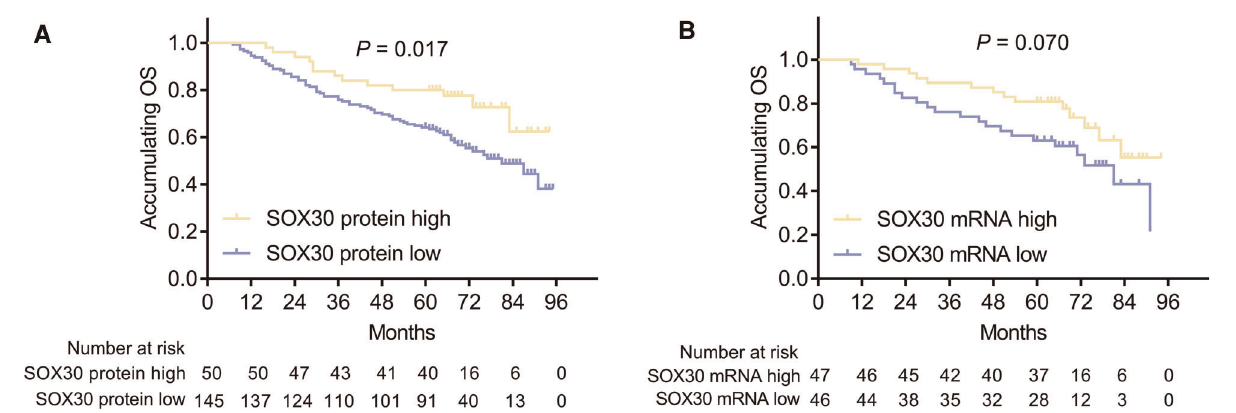
FIGURE 2 | Correlation between SOX30 expression and long-term prognosis among CRC patients. Correlation of SOX30 protein expression ( A ) and SOX30 mRNA expression ( B ) with accumulating OS. SOX30, sex-determining region Y-box containing gene 30; OS, overall survival; CRC, colorectal